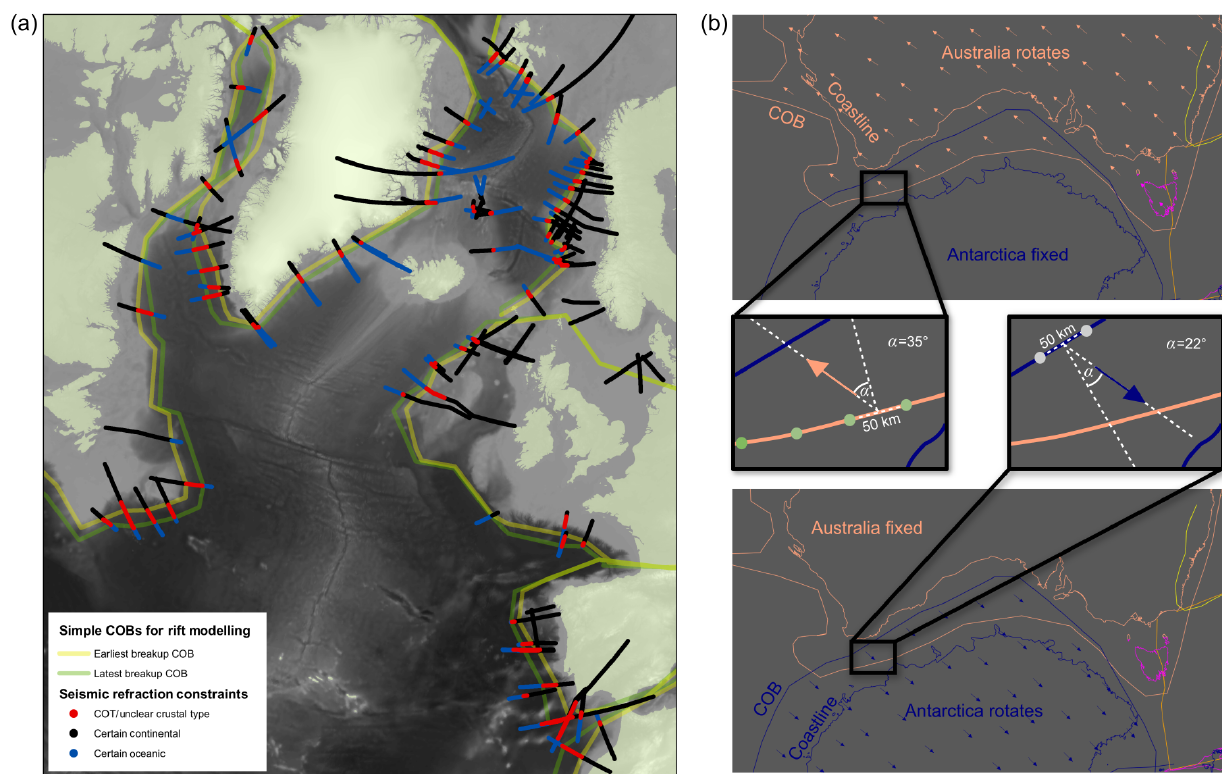
Figure 2. Methods illustration. (a) Endmember sets of continent–ocean boundaries (COBs) are based on seismic refraction data, here exem- plified for the North Atlantic. The latest breakup COB constitutes our reference model while the earliest breakup COB is used for robustness tests. (b) Kinematic analysis approach exemplified for Australia-Antarctica